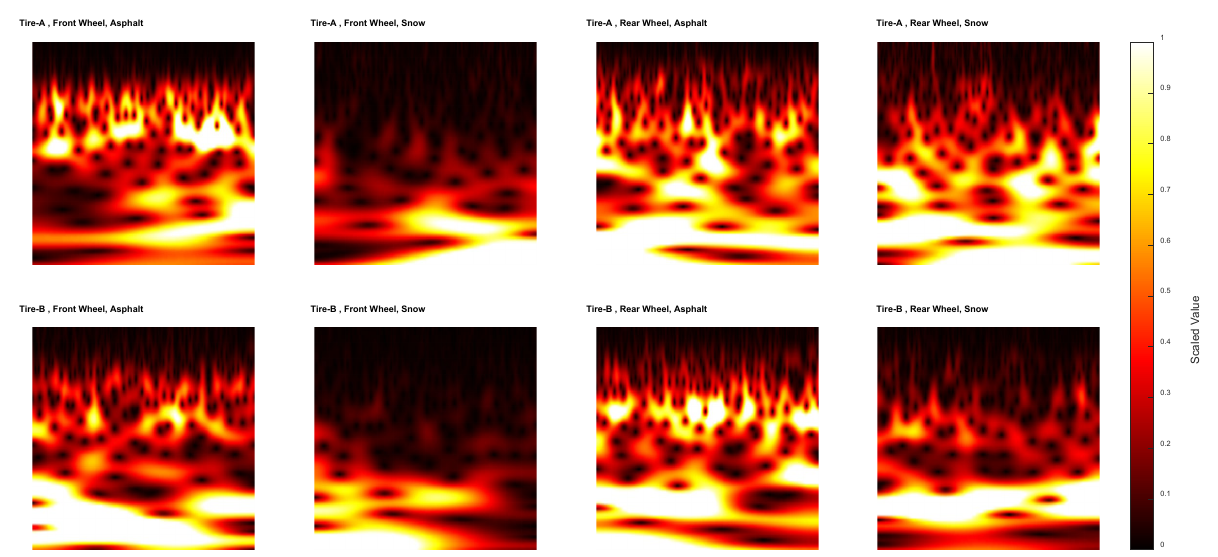
Figure 10. Sample of RGB images (224 × 224 × 3 pixels) used for input data of CNN architecture.